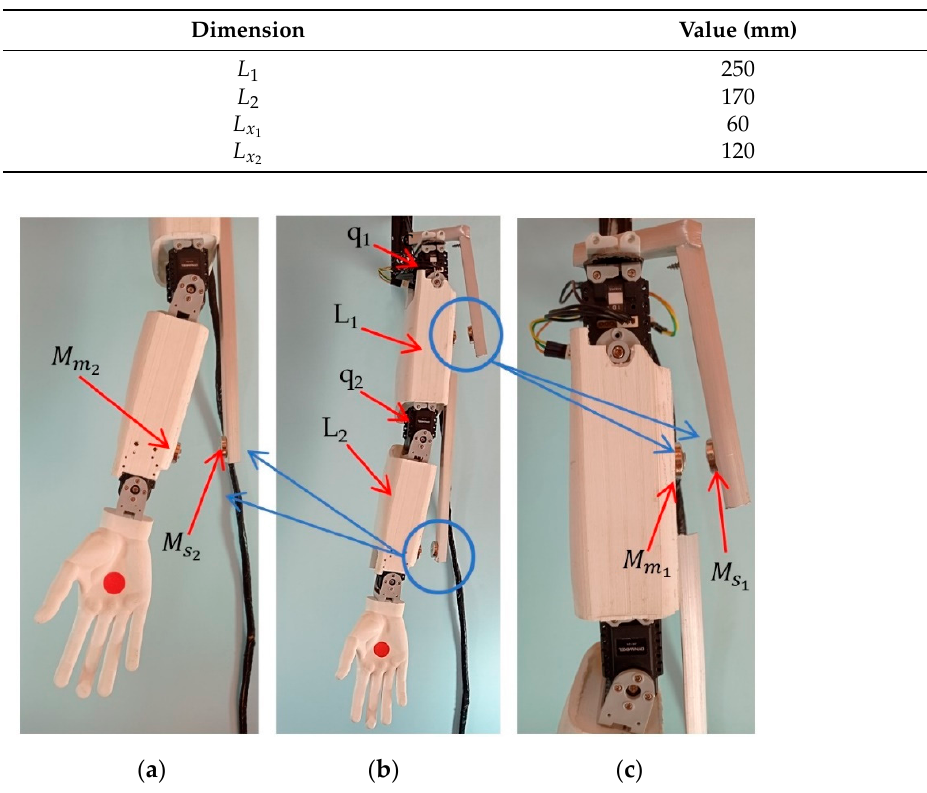
Figure 12. Prototype with the magnetic spring system: ( a ) forearm detail, ( b ) full arm detail, ( c ) arm detail.